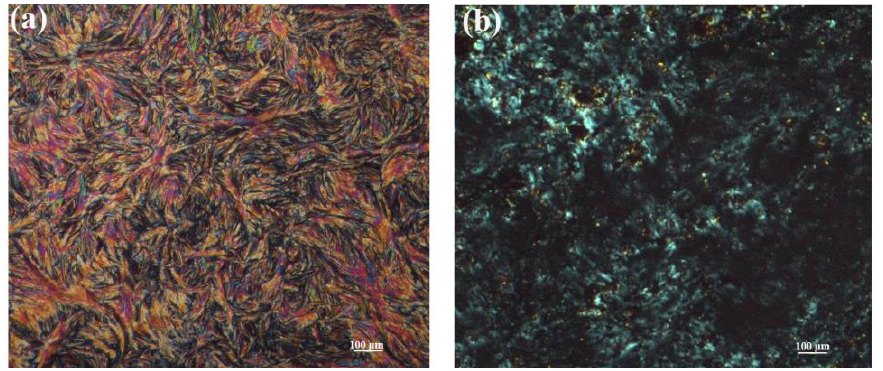
Figure 6. Polarizing microscope (POM) of the BP6 ( a ) and GPLP ( b ).